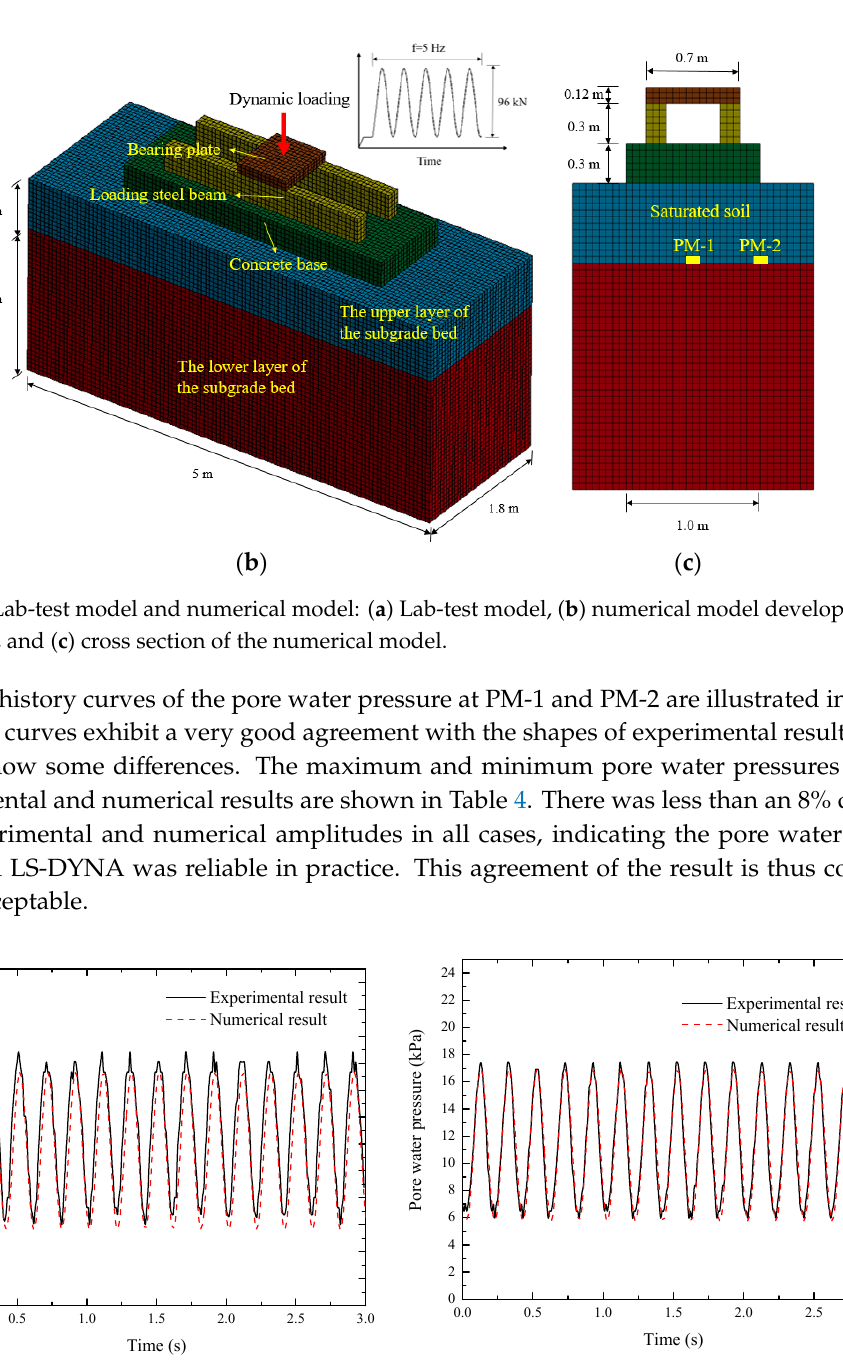
Figure 5. Time history curves of pore water pressure: ( a ) pore-water-pressure measurement (PM)-1 and ( b ) PM-2. Table 4. Maximum and minimum pore water pressures from experimental and numerical results.